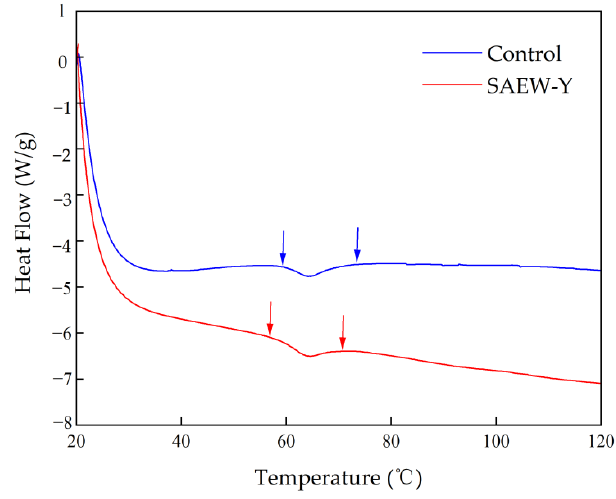
Figure 6. DSC profiles of different wheat tempering flour samples. Tempering wheat with distilled water (control) and tempering wheat with SAEW (SAEW-Y) flour samples at the same moisture content of 14% are shown.